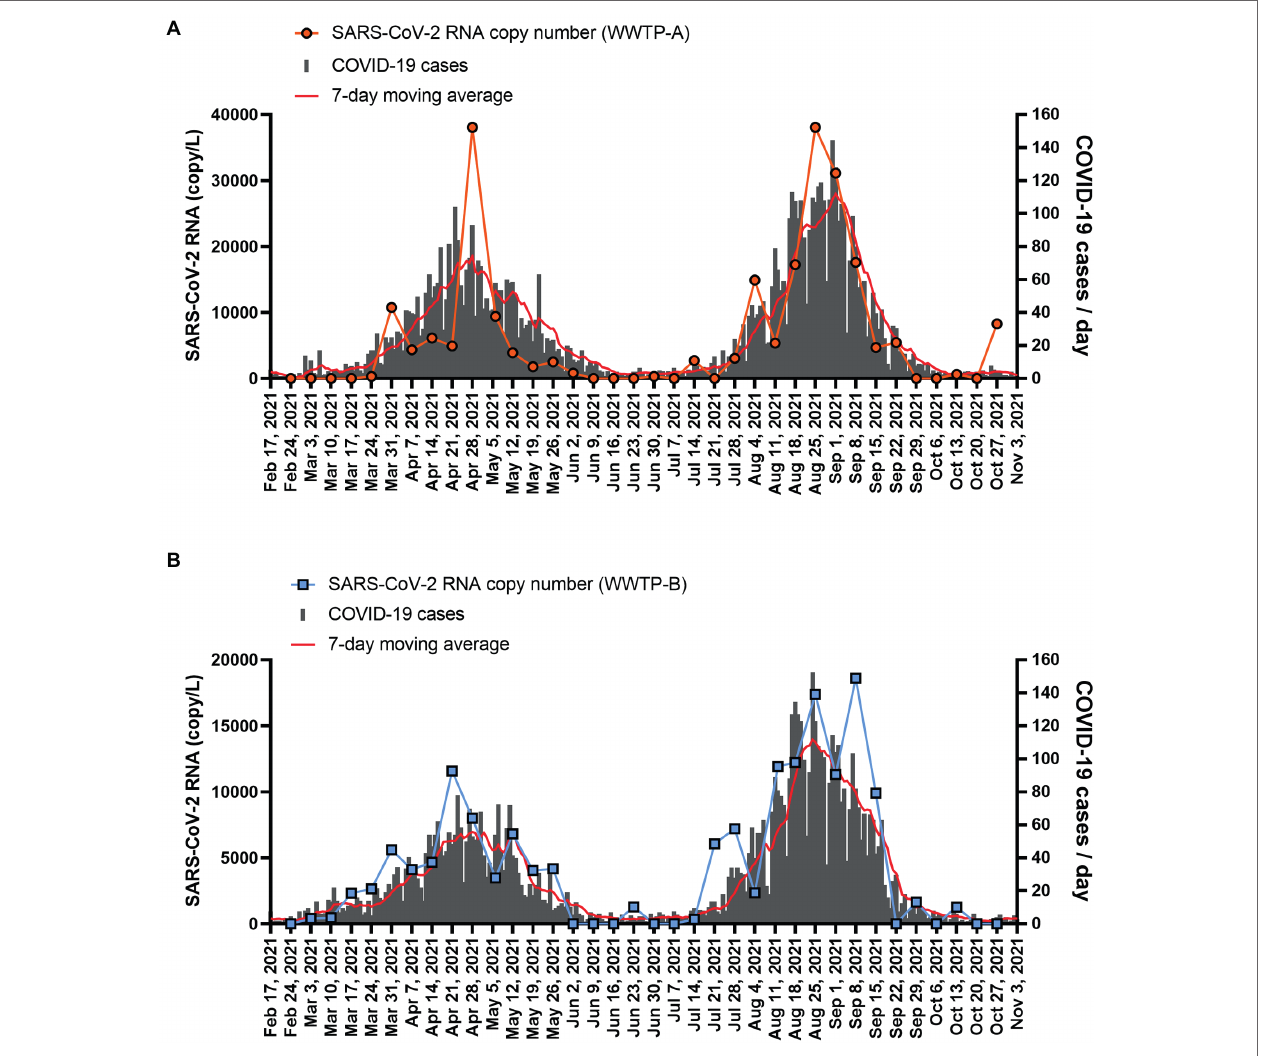
FIGURE 3 | SARS-CoV-2 RNA copy number in the solid fraction and COVID-19 case numbers. The SARS-CoV-2 copy numbers in the solid fraction from (A) WWTP-A (orange circle) and (B) WWTP-B (blue squares) are plotted. The number of new COVID-19 cases per day in WWTP basin is indicated by the gray bars, and the seven-day moving average is indicated by the red